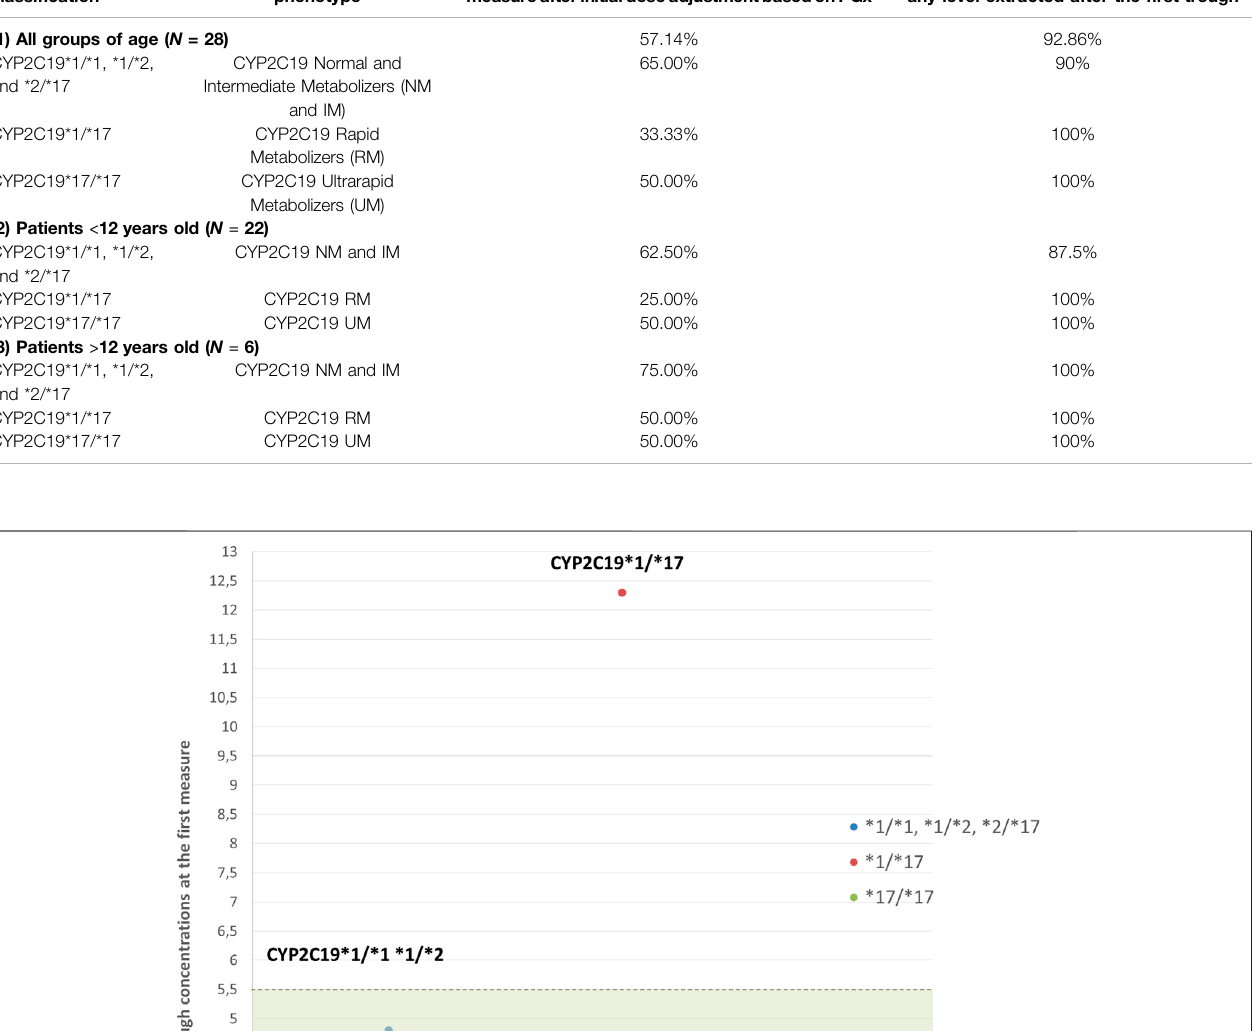
trough concentration determination. CYP2C19*1/*17 patients